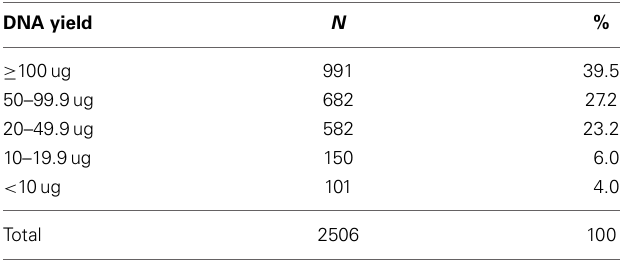
Table 2 | DNA yields obtained from N = 2506 4ml saliva sample isolations from first year